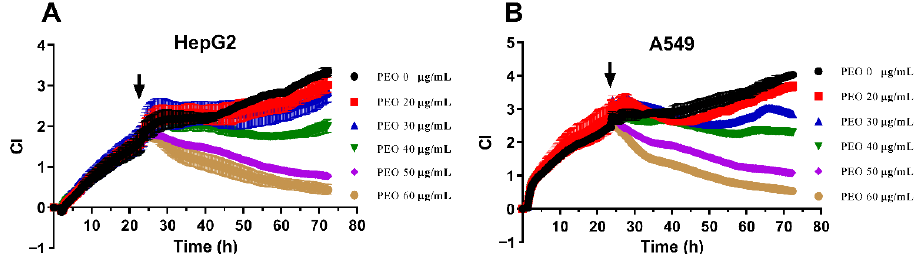
Figure 3. CI curves of ( A ) HepG2 cells and ( B ) A549 cells treated by increasing concentration of PEO. HepG2 and A549 cells were seeded into E-Plate96. E-Plate96 was locked in RTCA-DP device at 37 ◦ C with 5% CO 2 . Twenty hours postplating, cells were treated with different concentrations of PEO. CI was read automatically every 15 min and the recorded curves were normalized to the time point of cell seeding, referred to as normalized CI. All experiments were performed in triplicate. Point of PEO addition is shown by a black arrow.